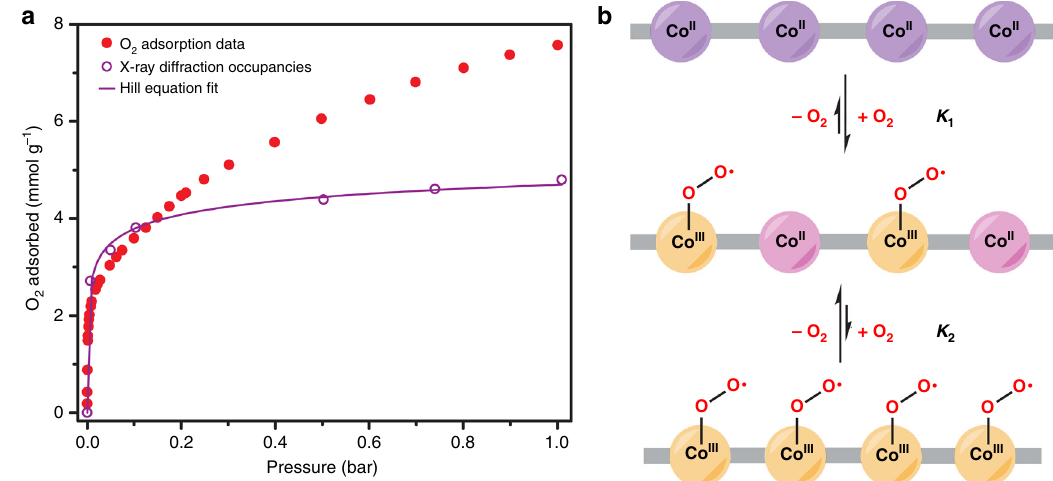
Fig. 6 Negative cooperativity of O 2 binding. a Oxygen adsorption isotherm obtained at 195 K for Co 2 (OH) 2 (bbta) ( fi lled red circles) plotted alongside values obtained for superoxo occupancies under similar conditions with powder X-ray diffraction data, multiplied by the theoretical capacity of 6.45 mmol g − 1 (open purple circles). Modeling these occupancy values using the Hill equation resulted in excellent agreement (solid purple line; Supplementary Information Sections 8). At low pressures, the projected capacity values from the diffraction occupancies are very slightly higher than the experimental adsorption capacities, which may be due to adsorption at defects (e.g., surface sites) that are not re fl ected in the occupancies. At higher pressures, the signi fi cant deviation of the gas adsorption from the projected occupancy capacities is due to physisorption within the pore. Source data are provided as a source data fi le. b Simpli fi ed illustration of a chain of cobalt centers in Co 2 (OH) 2 (bbta) running along the c-axis in the activated material (top), following oxidation to generate cobalt(III)-superoxo species (yellow spheres) and unreacted, less electron-rich cobalt(II) ions (pink spheres) (middle), and the fully oxidized cobalt(III)-superoxo chain (bottom). From analysis of the variable-temperature O 2 adsorption data, the equilibrium constant for partial O 2 loading ( K 1 ) is estimated to be much larger than the equilibrium constant to achieve 100% occupancy ( K 2 ). As a result, the partially oxidized material dominates under all conditions studied